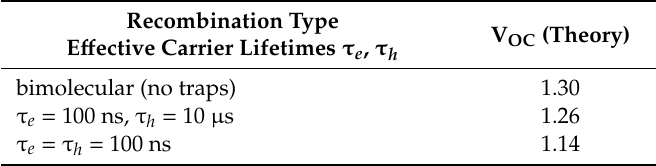
Table 1. Calculated open-circuit voltage (V OC ) for the case of pure bimolecular recombination, short-lived electrons and long-lived holes, as well as for short lived charge carriers. Reproduced with permission from Energy Environ. Sci. 2016 , 9 , 3472–3481. Reference